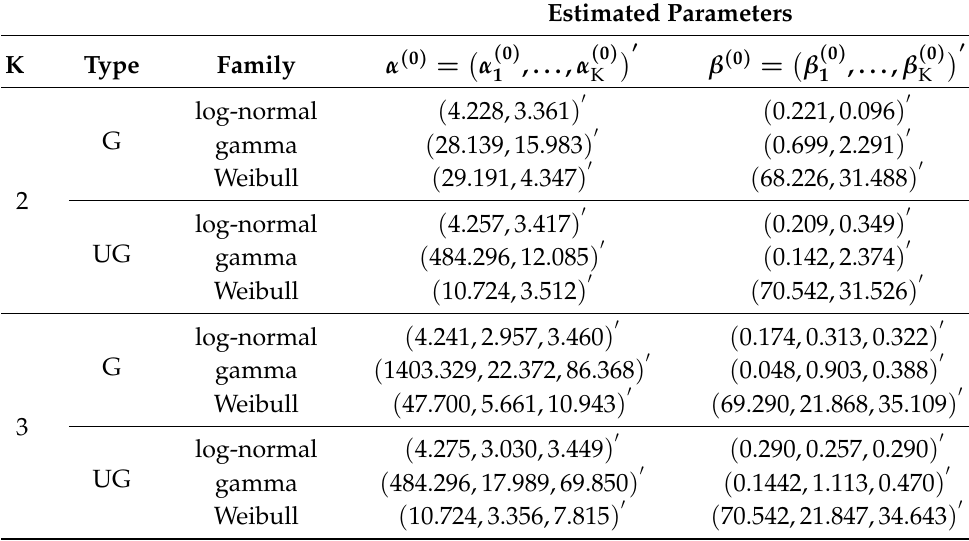
Table A2. Initial values of the EM algorithm for sample 2 obtained using the K-means clustering approach when DBH data are ungrouped (UG) and grouped (G) in classes of width 5 cm. It should be noted that the estimated vector of mixing parameters is not given for the sake of saving